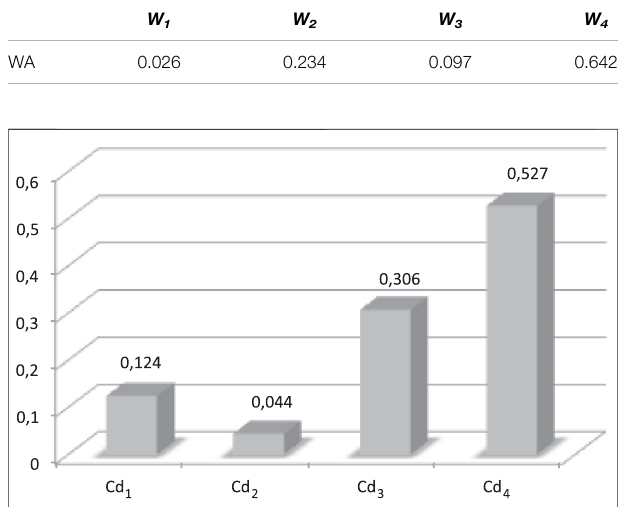
TABLE 8 | Scores and ranking for the scenario in nominal mode for the CI and the WA operators.